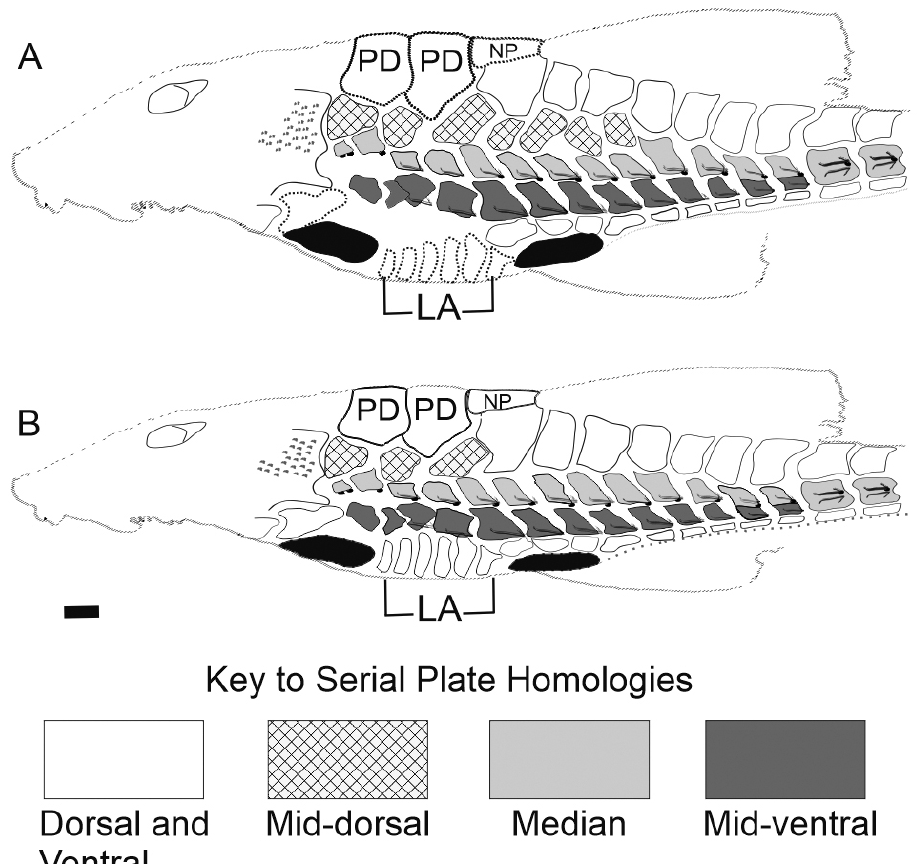
FIGURE 1 | Schematic illustration of lateral plate series in species of Rineloricaria with ( A ) extended (described in this study) and ( B ) short ( e.g. , R. steindachneri ) mid-dorsal series. The black areas indicate the insertion of the pectoral and pelvic fins. LA: lateral abdominal plates; PD: predorsal plates; NP: nuchal plate. Scale bar = 2